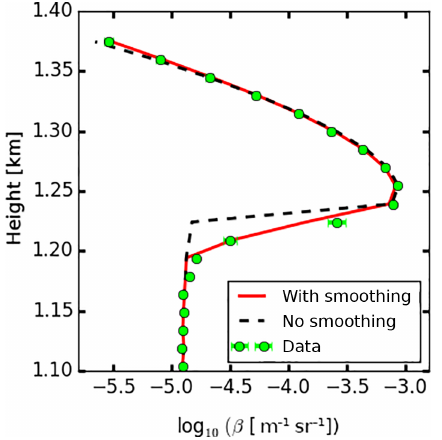
Figure 2. Lidar attenuated backscatter profiles as a function of height. The circles outline an example of a measured β profile, taken during the ACCEPT campaign on 26 October 2014 at 5.04UTC. The dashed black line shows the forward-modeled β that best fits the measurements when no smoothing is applied to LWC. The solid red line represents the forward-modeled β when LWC is